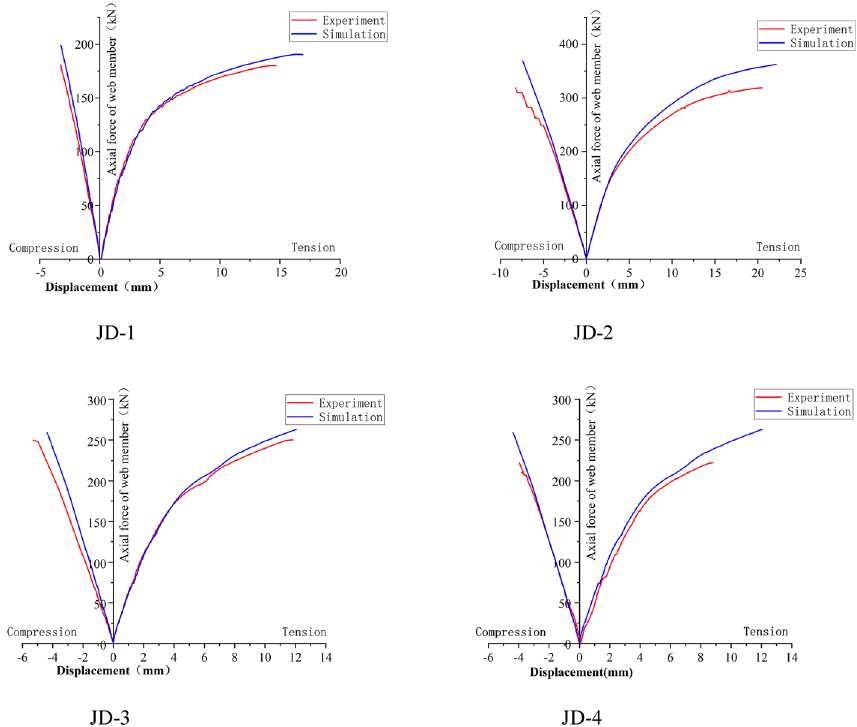
Figure 18. Comparison diagram of load–displacement curve of web member.